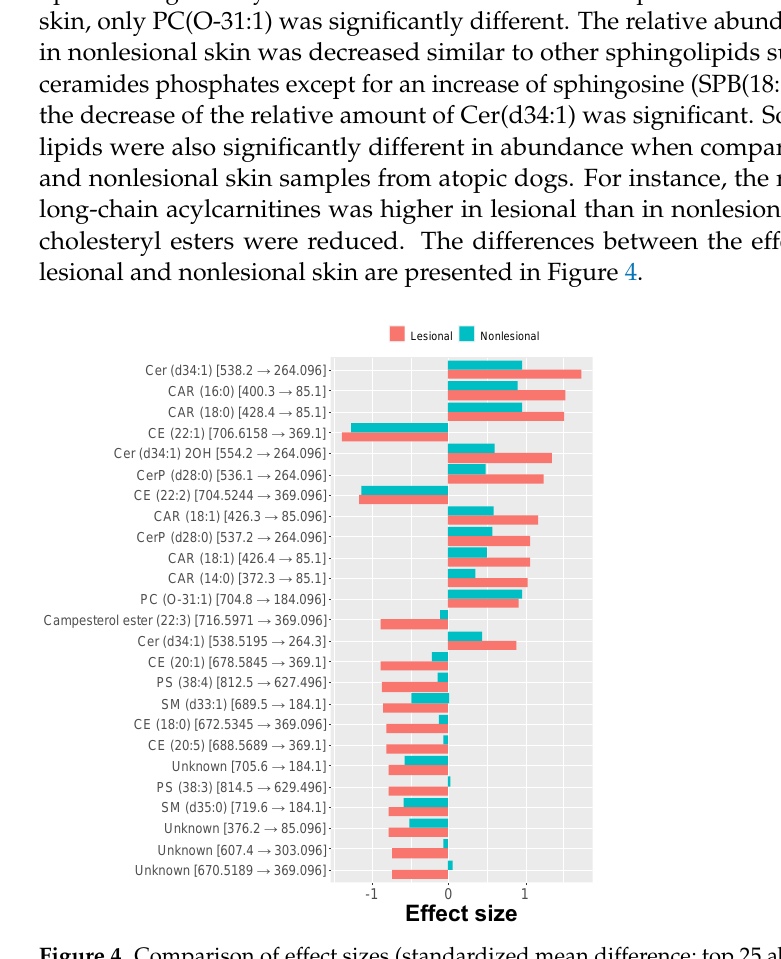
Figure 4. Comparison of effect sizes (standardized mean difference; top 25 absolute values) observed between lipid abundances present in swabs collected from CAD (lesional and nonlesional skin) vs. healthy dogs. The nonlesional skin is affected to a lesser extent than lesional skin.